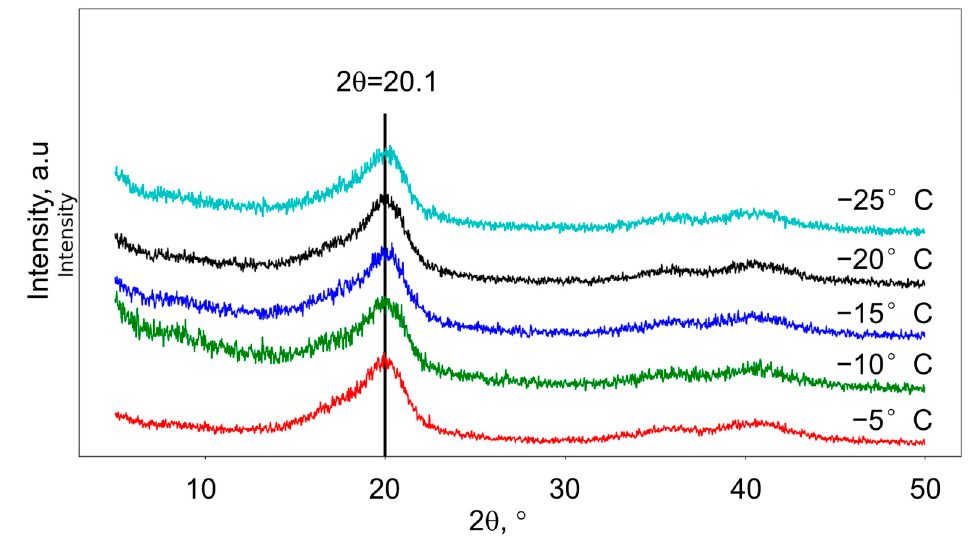
Figure 5. XRD spectra of membranes produced at different freezing temperature.